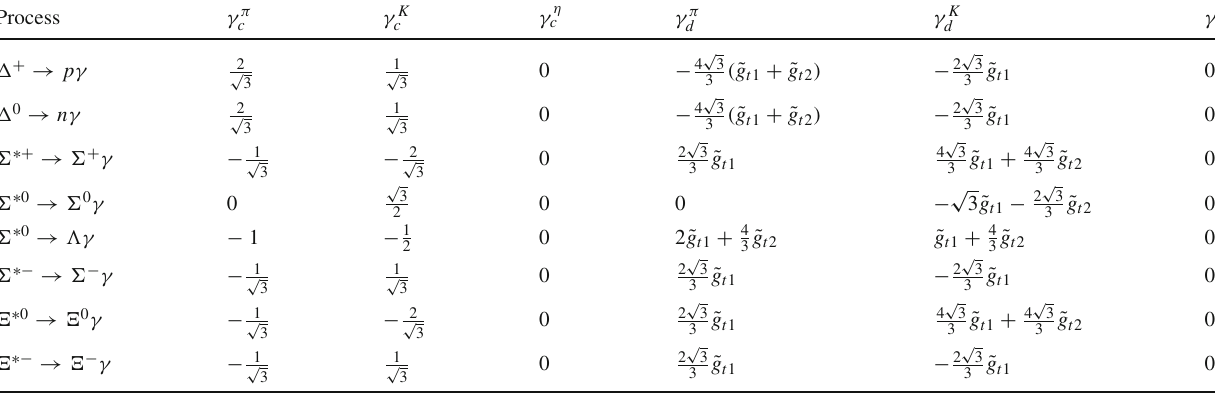
Table 8 The coefficients of the loop corrections to the decuplet to octet baryon transition magnetic moments from Figs. 2(c) and 2(d)